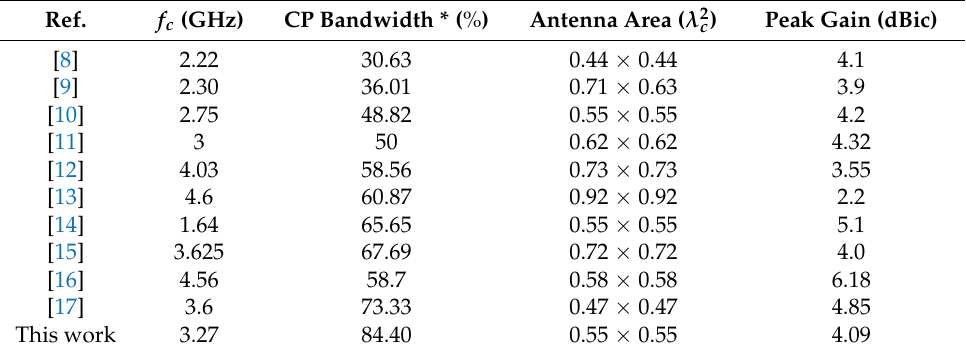
Table 2. Performance comparison with previous broadband circularly polarized (CP) slot antennas.